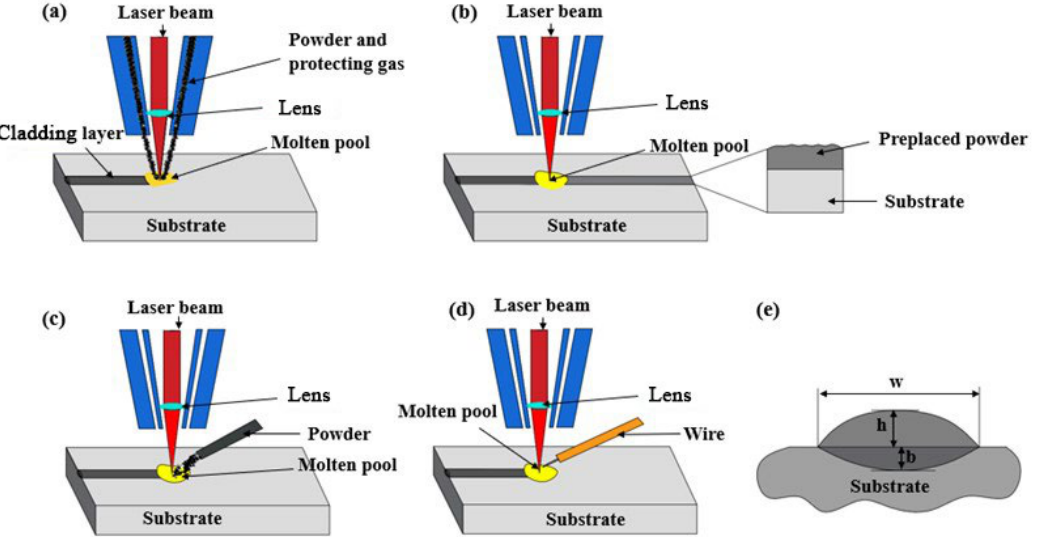
Figure 3. Schematic diagrams of the LC processing mode: ( a ) coaxial powder feeding method; ( b ) pre-placed powder method; ( c ) off-axis powder feeding method; ( d ) wire feeding method; ( e ) cross- sectional morphology of the cladding region.